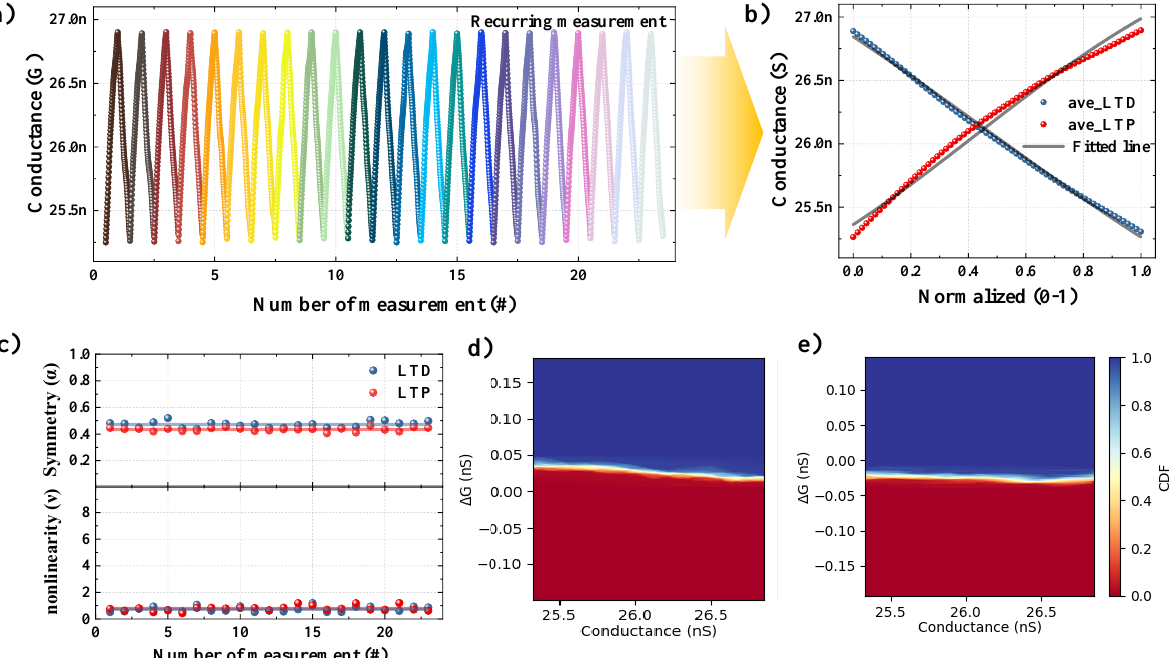
Figure 5. Synaptic characteristics using an optimized spike condition. ( a ) Long-term potentiation (LTP) and long-term depression (LTD) over 23 cycles with optimized spike conditions. ( b ) Averaged and normalized LTP and LTD fitted to the symmetric non-linear model. ( c ) Individual symmetric center points (upper panel) and non-linearity (lower panel) of LTP and LTD over 23 cycles. Conductivity deviation of ( d ) LTP and ( e ) LTD as statistically calculated by applying the cumulative distribution function.